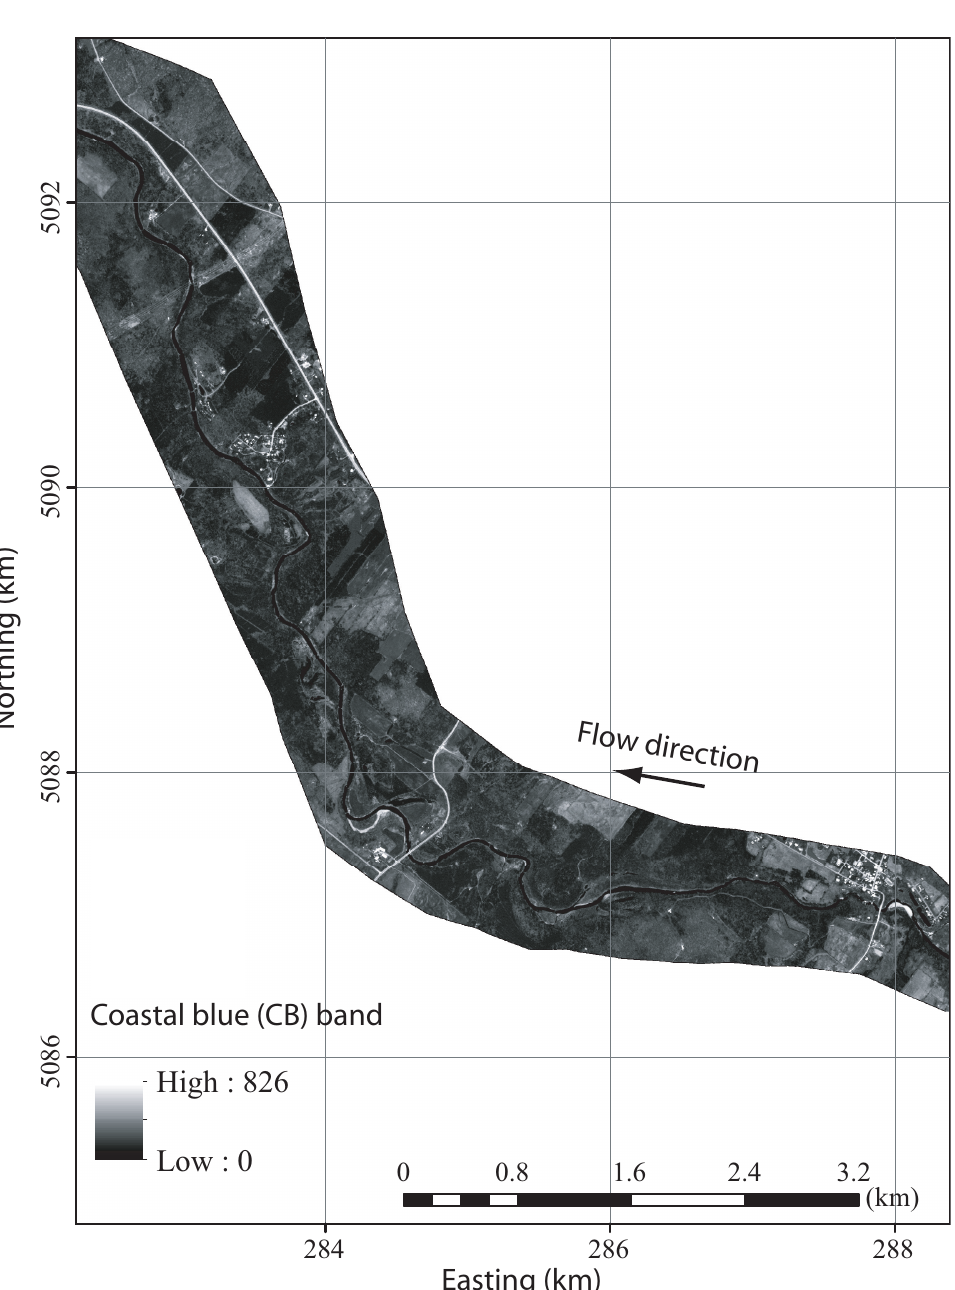
Figure A1. Values of the digital number N (or pixel values) in the coastal blue band (Table